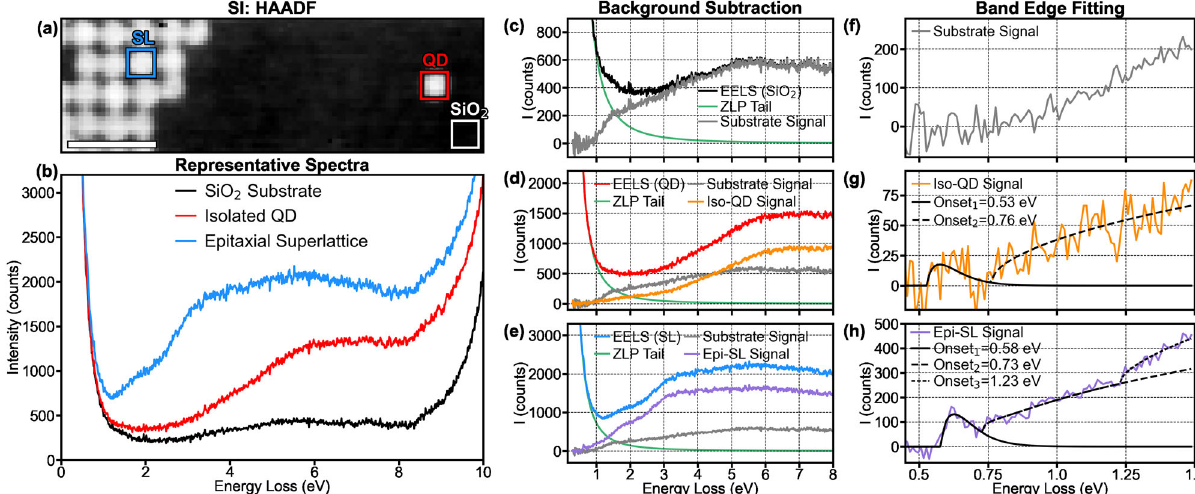
Fig. 3 | EELS identi fi cation of distinct electronic states in the epi-SLs. a HAADF reference imagefrom the SIacquired of a region with a single iso-QD in proximity to an area of epi-SL. b Three representative spectra from different regions in the spectral image representing the SiO 2 substrate signal, an iso-QD, and the epi-SL. The pixels used for the representative spectra are labeled in a . c – e The representative spectra from ( b ) with a power law background subtraction to remove the elastic scattering (ZLP) tail, revealing the shape of the signal from the